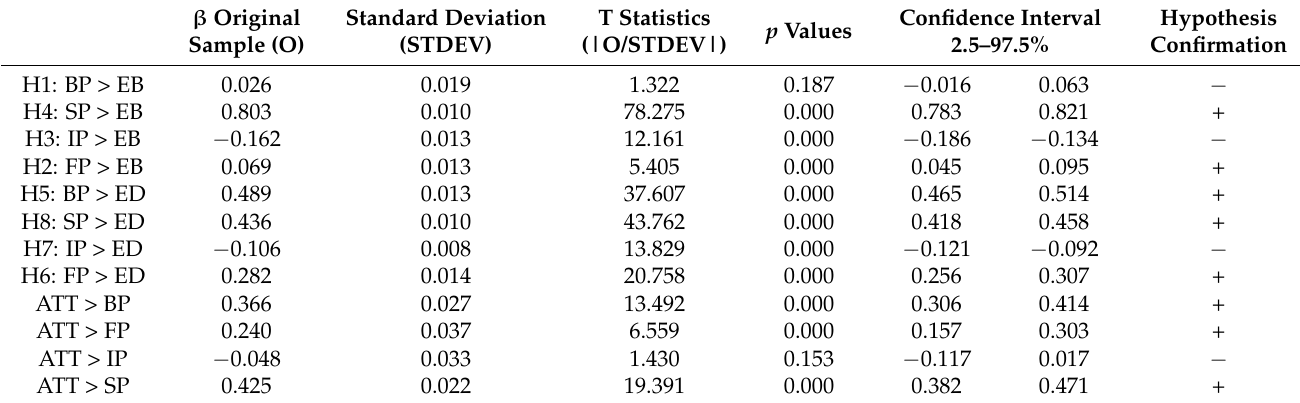
Table 8. Results of hypothesis testing using the PLS-SEM technique.